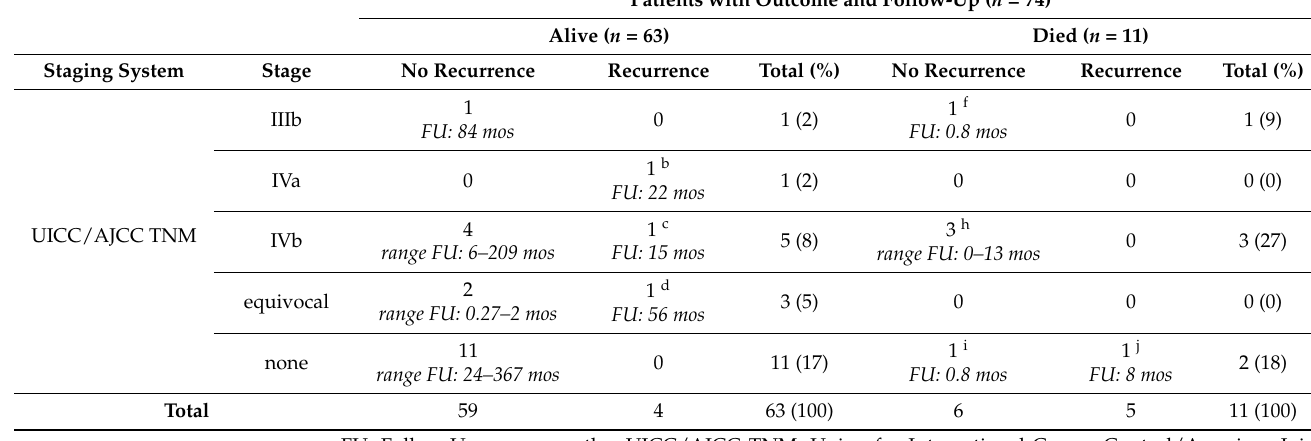
Patients with Outcome and Follow-Up ( n = 74)